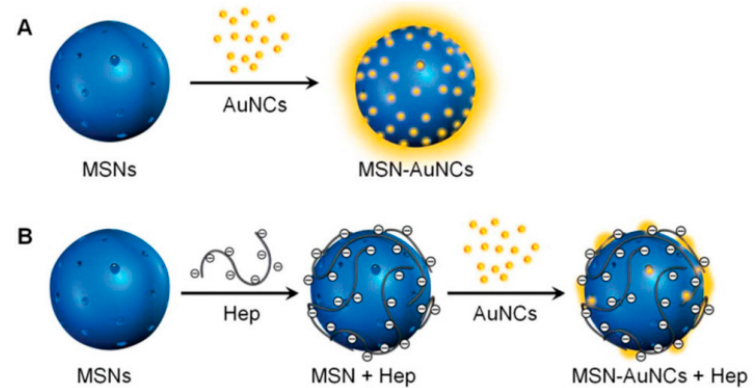
Figure 9. Schematics illustrations of ( A ) the self-assembly of mesoporous silica nanoparticle (MSN)- AuNC nanocomposites, and ( B ) the detection of heparin. Adapted with permission from Reference [46] Copyright (2018) Royal Chemistry